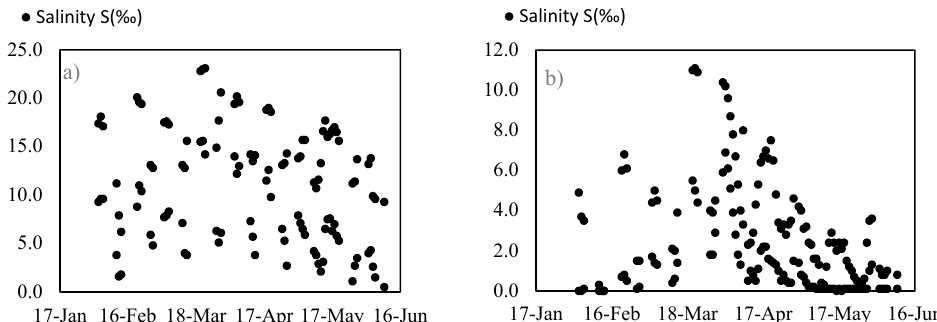
Figure 2. The salinity concentration at Tran De ( a ) and Dai Ngai ( b ) stations in the dry season of 2011.